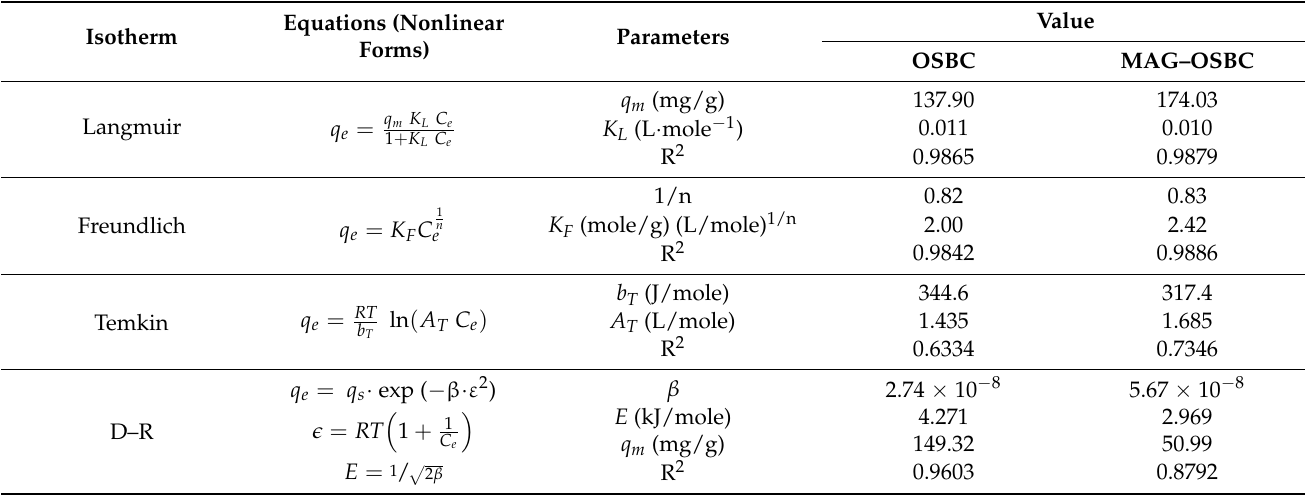
Table 6. Nonlinear equations of Langmuir, Freundlich, Temkin and Dubinin–Radushkevich (D–R) isotherms, besides their parameters for the adsorption of CLOF onto both OSBC and